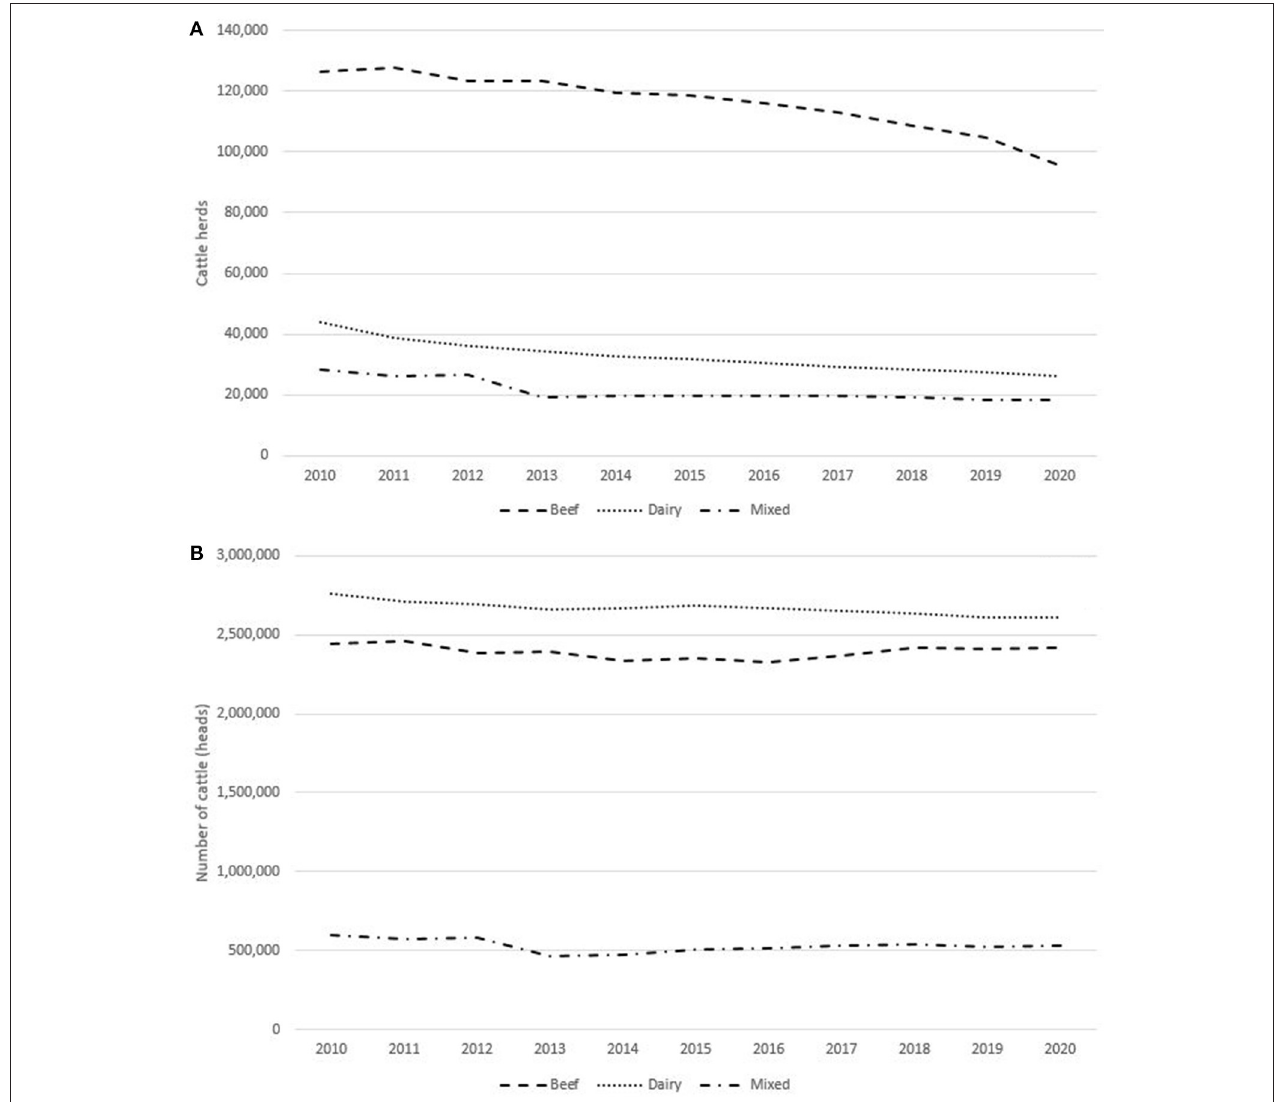
FIGURE 2 | Trends in cattle populations ( A herds, B animals), Italy